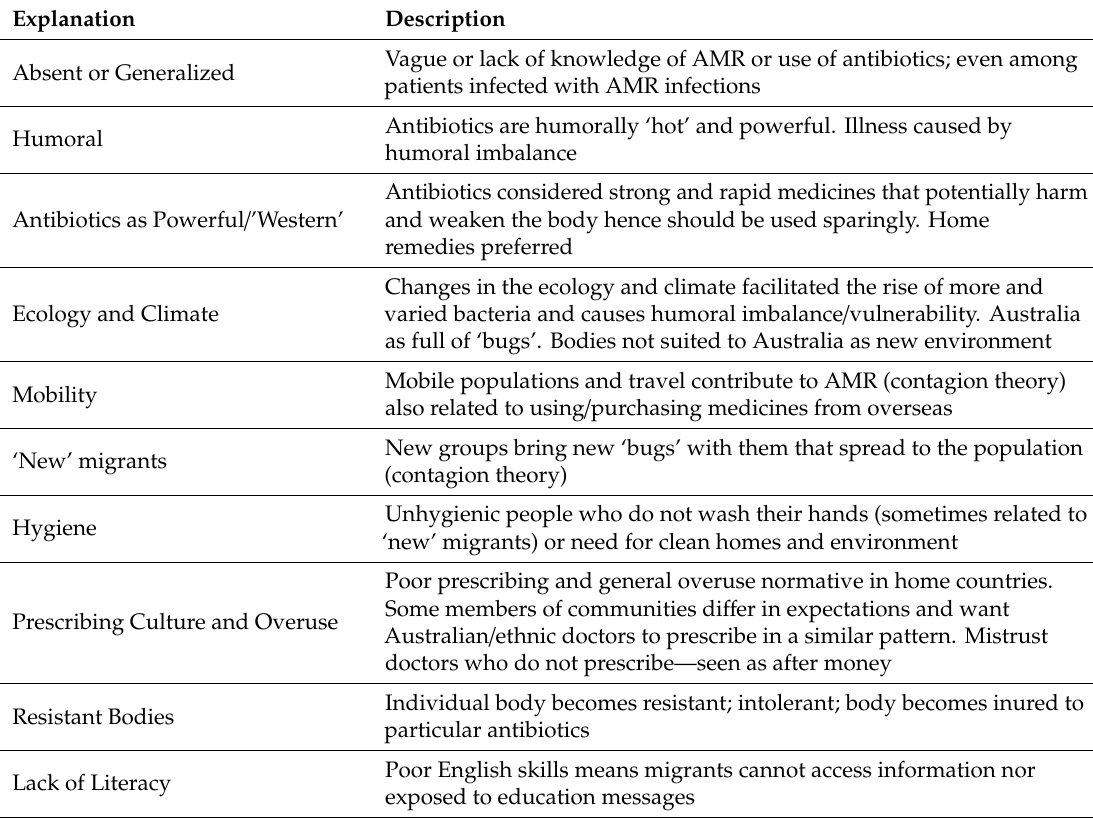
Table 1. Summary of lay explanations of antibiotics and antimicrobial resistance (AMR) from migrant informants with